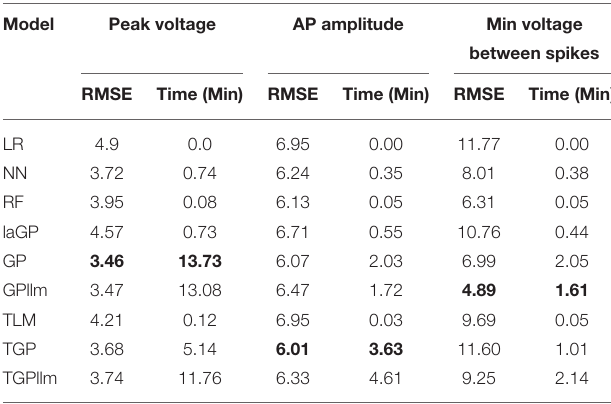
TABLE 6 | RMSE and run time for emulating generation 6